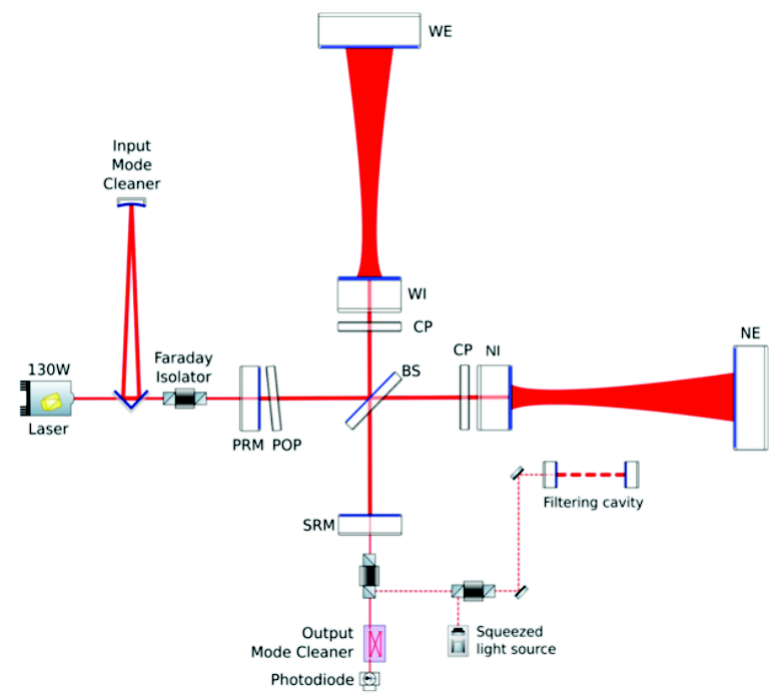
Figure 2. AdV+ target optical layout, including the PR mirror (PRM), SR mirror (SRM), beam splitter (BS), and two Fabry–Perot resonant cavities (WI-WE and NI-NE